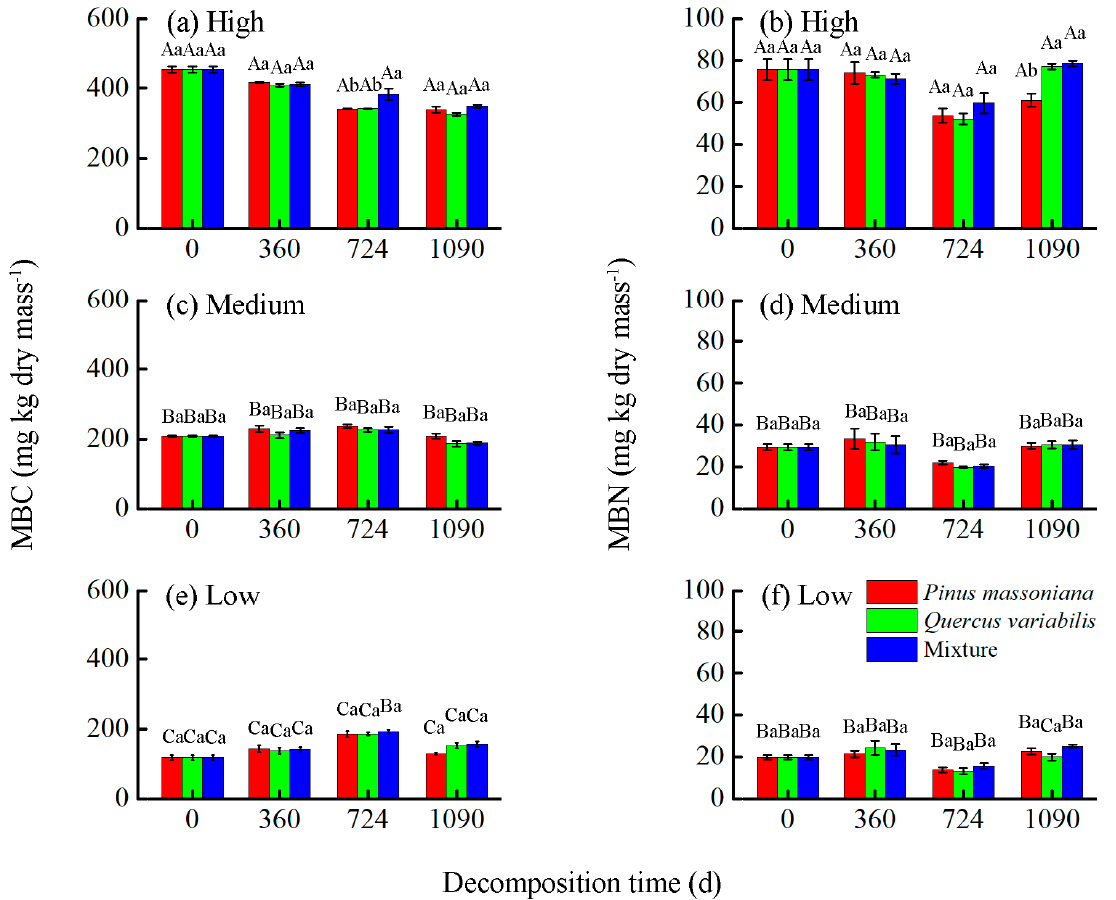
Figure 3. Dynamic of soil microbial biomass for carbon ( a , c , e ) and microbial biomass nitrogen ( b , d , f ) among the litter types in different soil nutrient substrates during decomposition. Values are the mean ± SE ( n = 3). Different capital letters indicate a significant difference among soil substrates for the same litter type at the same decomposition time; different lowercase letters indicate a significant difference among litter types for the same soil substrate at the same decomposition time ( p < 0.05).